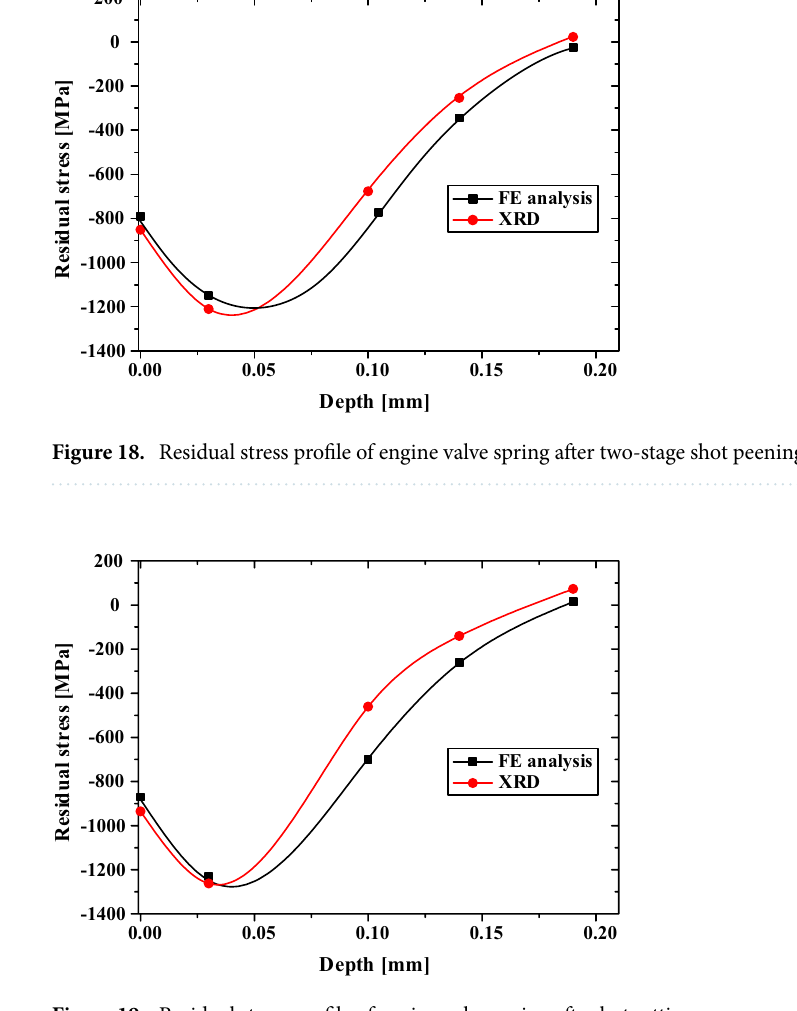
Figure 19. Residual stress profile of engine valve spring after hot